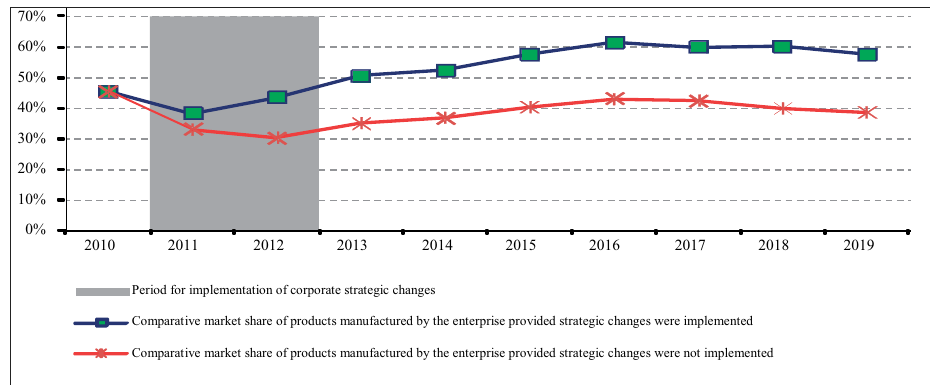
Fig. 4. Dynamics of the market share of products manufactured by the enterprise 9 ( E 9 In the Baltic region.